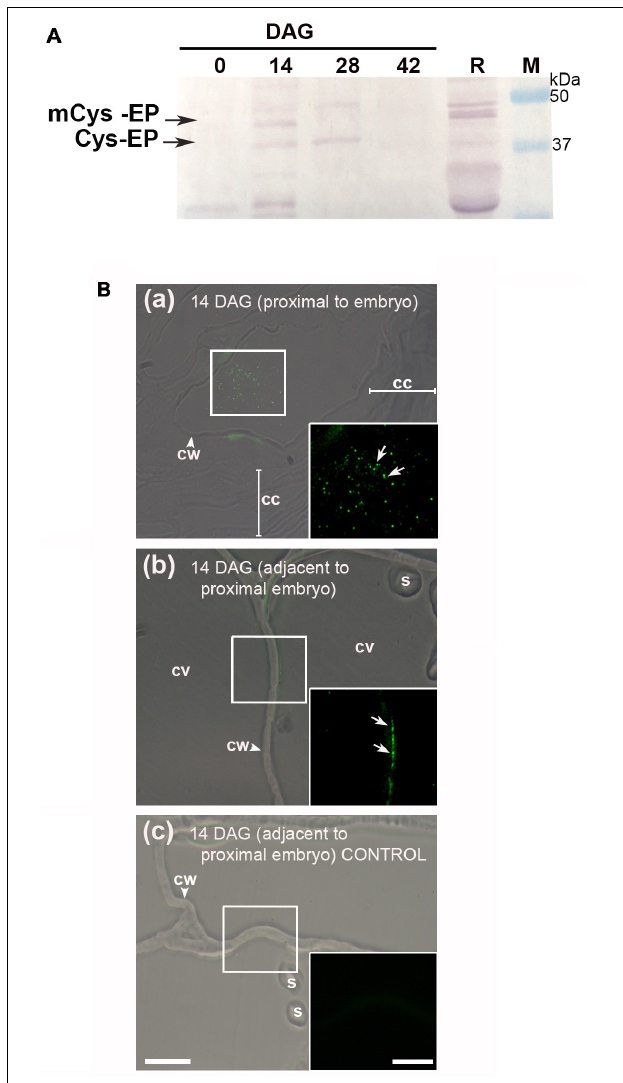
FIGURE 3 | Immunodetection of Cys-EP in A. angustifolia megagametophytes, during germination. (A) Western blot analysis with anti-RcCys-EP as primary antibody. Proteins from 0, 14, 28, and 42 DAG were separated on a 12% polyacrylamide gel and then transferred to a PVDF membrane. As a control, proteins were extracted from 5 DAG R. communis seeds. Analyses were repeated at least three times on independent biological samples, and representative results are shown. (B) In situ immunolocalization of Cys-EP in megagametophytes of A. angustifolia at 14 DAG. Merge bright field and fluorescence imaging of longitudinal sections shows Cys-EP selectively localized to the proximal sector of the embryo (a) and adjacent to the proximal sector of the embryo (b) at 14 DAG; note labeling in the cytoplasm next to the cell wall (b) . (c) negative control. Scale bar: (a–c) = 20 µ m. Inset = 10 µ m. Abbreviations: cc , crushed cells; cv , central vacuole; cw , cell wall; s, starch. Each image is a representative result